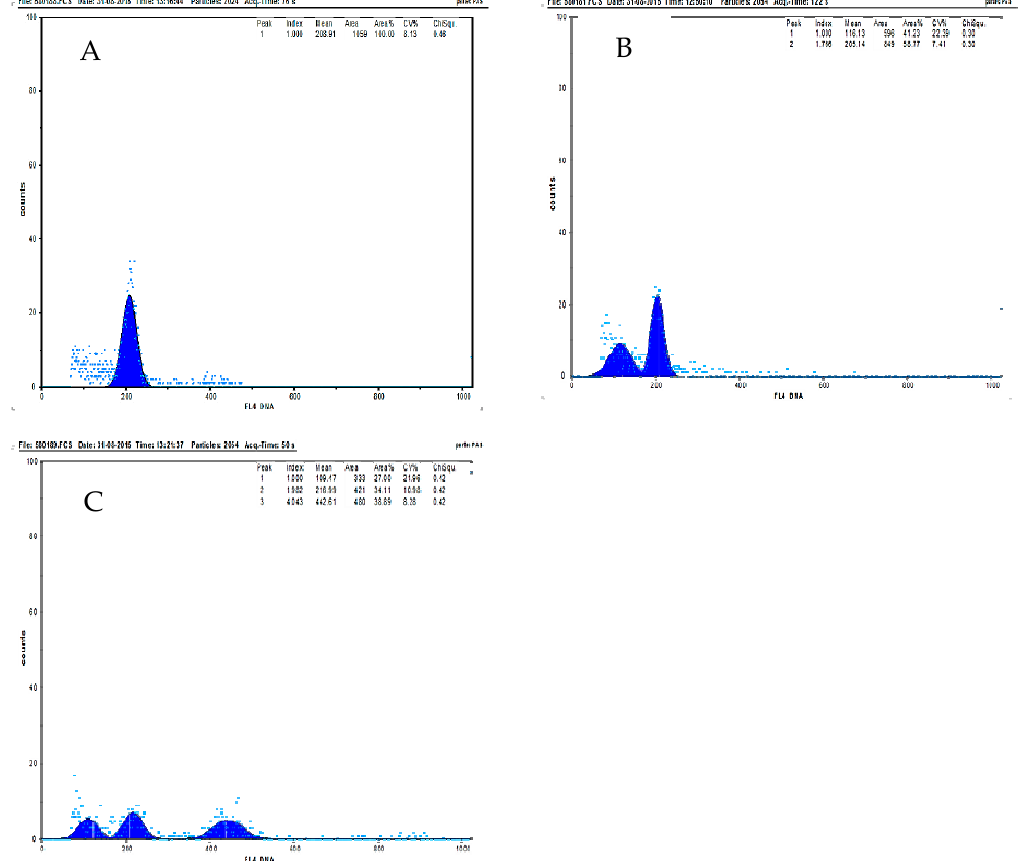
Figure 6. Histogram of the relative fluorescence intensity of nuclei isolated from ( A ) J . curcas L., ( B ) R . communis L., and ( C ) intergeneric hybrid (JR6) treated with 0.3% colchicine for three days.